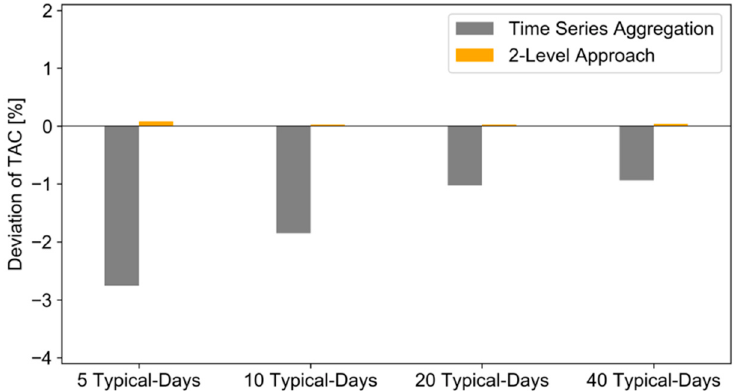
Figure 4. Deviation of total annual costs for different typical days compared to full time series.